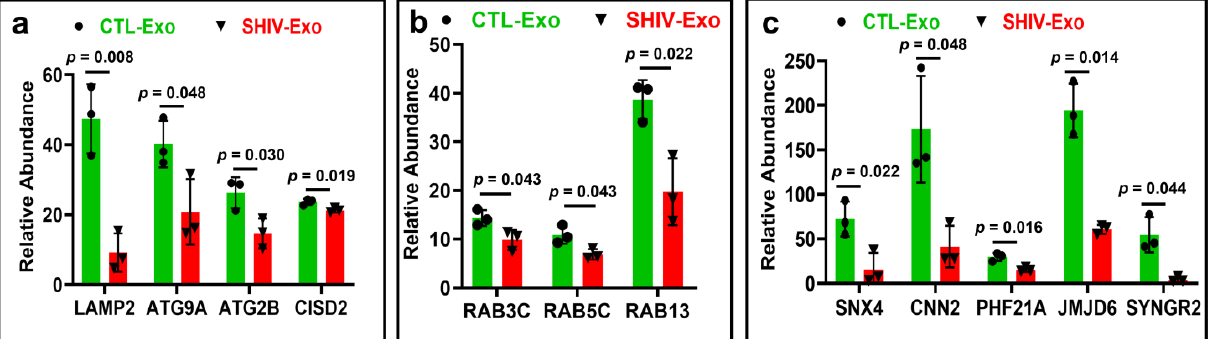
Figure 7. Decreased expression of proteins involved in autophagy, endosomal recycling, exocytosis, and sprouting angiogenesis in SHIV-Exo. ( a – c ) Differential expression of proteins involved in au- tophagy, endosomal recycling, exocytosis, and sprouting angiogenesis in CTL-/SHIV-Exo quantified by proteomic analysis. Proteins exhibiting group differences are shown as bar graphs with green and red for CTL-Exo and SHIV-Exo, respectively. Graphs show mean ± SD of relative abundance calculated from four experimental replicates/sample. All protein groups passed the Shapiro– Wilk normality test. The data sets were followed by unpaired t test with Welch correction for nor- mally distributed data. The protein coding gene names are presented here and were described in the text. CTL-Exo: Plasma exosomes isolated from uninfected RM; SHIV-Exo: Plasma exosomes iso- lated from SHIV-infected RM (N = 3/group). q-values for: ( a ) 0.036, 0.048, 0.041, 0.038; ( b ) all of them